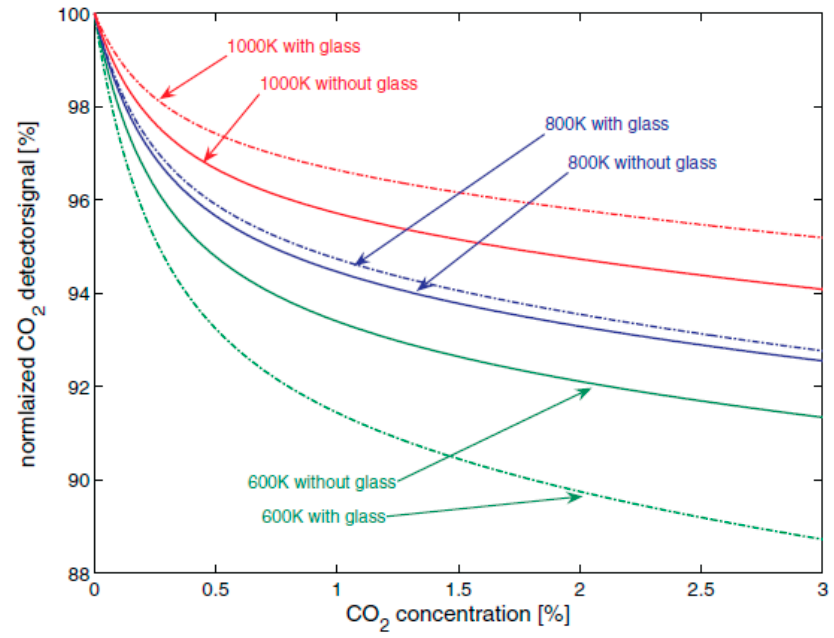
Figure 6. Carbon dioxide determination using glass filters. Reproduced with permission from Reference [15].